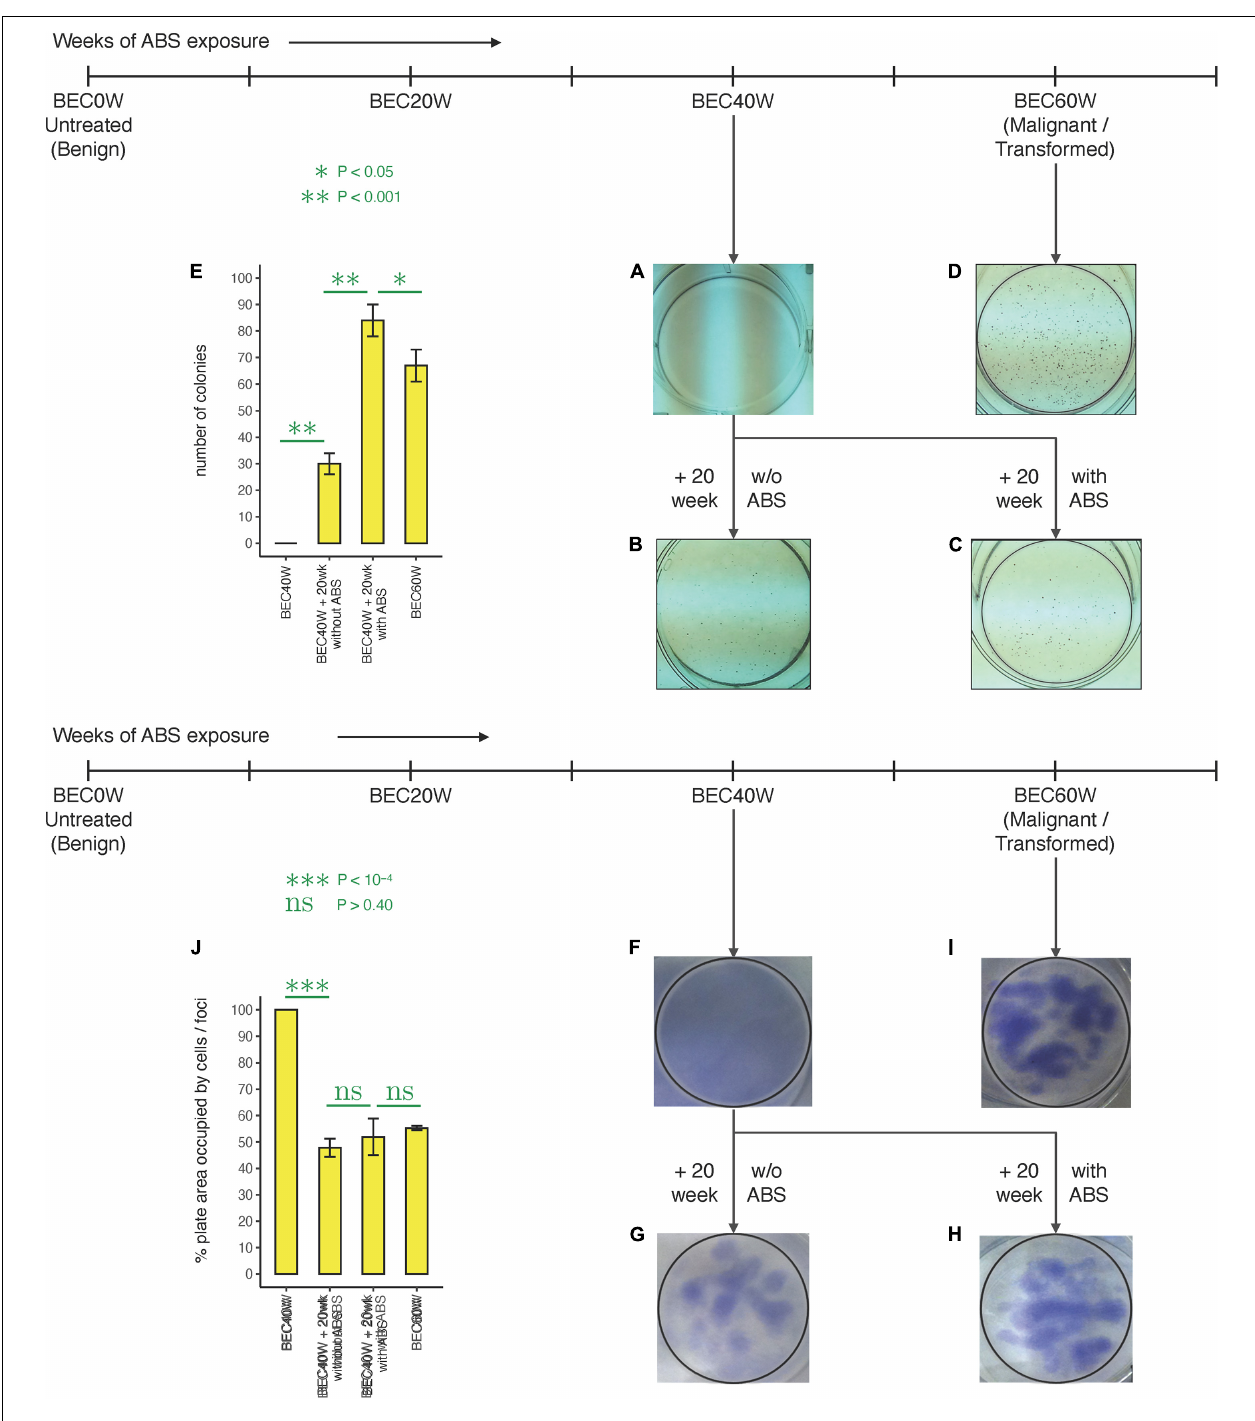
FIGURE 4 | Colony formation in different stages of BEC model: (A) The BEC40W cells do not initially form colonies in soft agar. (B) BEC40W + 20 weeks begin to form distinct colonies demonstrating loss of substrate adherence dependence after 20 weeks even in the absence of any further ABS. (C) The BEC40W + 20 weeks further exposed to ABS form more colonies comparable with the BEC60W cells (D) that retain their ability to form colonies even in the absence of stimulation after thawed from storage (representative pictures). (E) Total number of colonies compared between the BEC40W + 20weeks with the ABS and without ABS groups, and the BEC60W cells. Foci formation in different stages of BEC model : (F) The BEC40W cells do not initially form foci when confluent. (G) BEC40W + 20 weeks cells begin to form distinct foci demonstrating loss of contact inhibition after 20 more weeks even in the absence of any further ABS (H) . The BEC40W + 20 weeks further exposed to ABS form colonies as expected comparable with BEC60W cells (I) that retain their ability to form foci even in the absence of stimulation after thawed from storage (representative pictures). (J) Percent plate surface occupied by the foci (dark staining patches of multilayered cells) was compared with the monolayer of cells (BEC40W) covering the entire plate